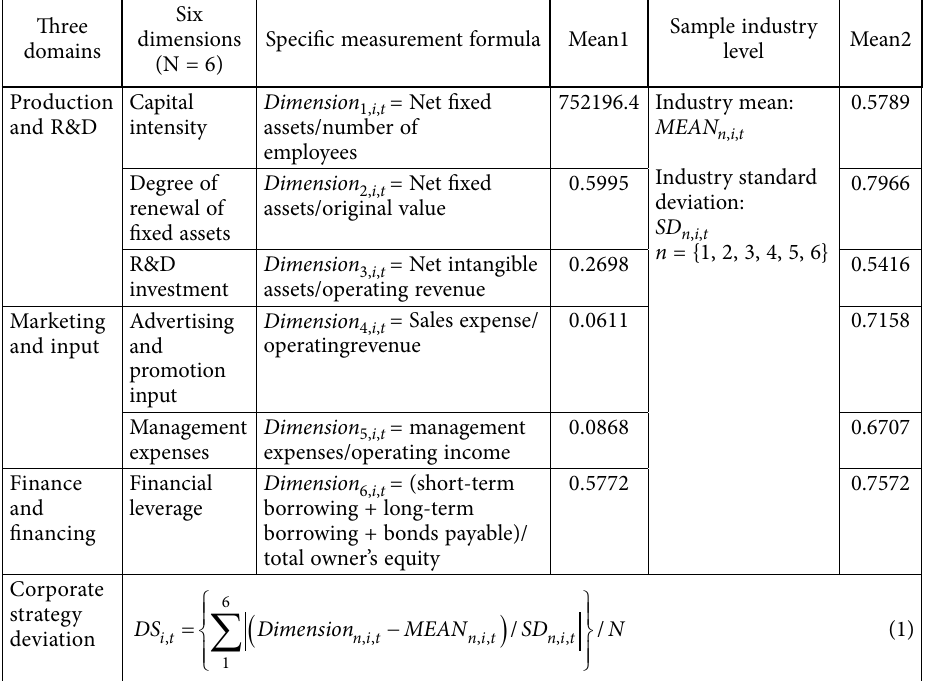
Table 1. Classification and measurement of strategy deviation of enterprises Three domains